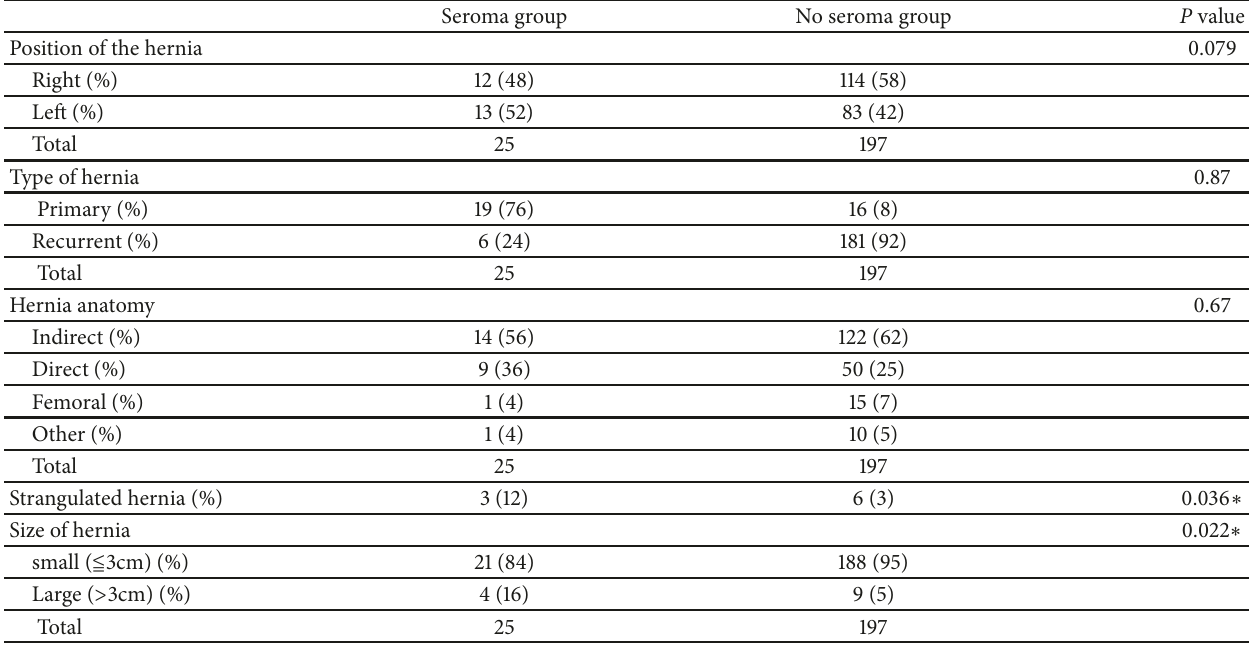
Table 3: Hernia data.